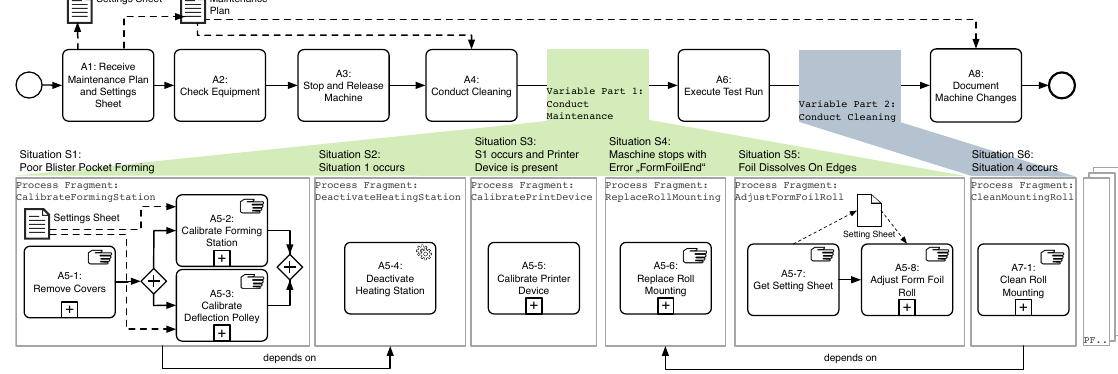
Figure 6. Excerpt of a machine maintenance process model (simplified).